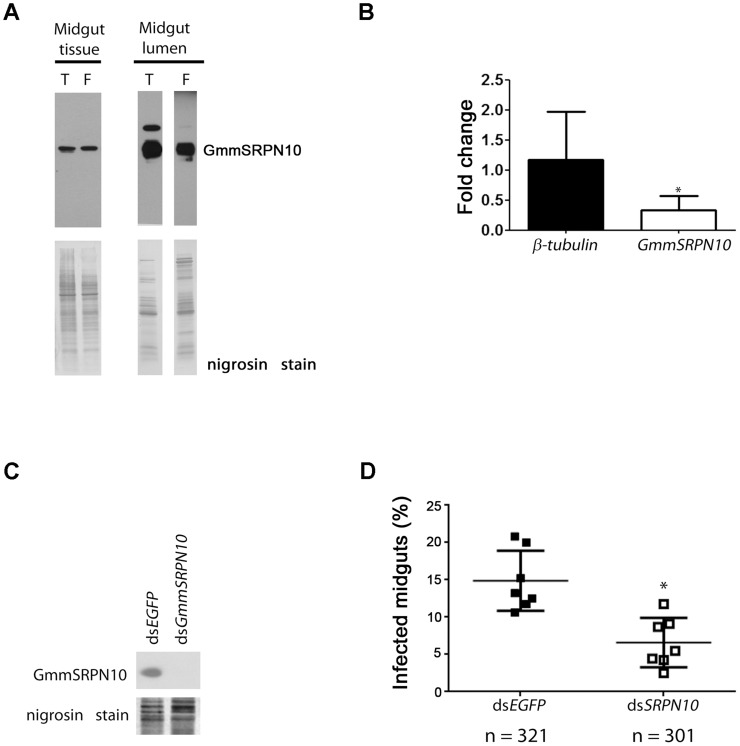
GmmSRPN10 is secreted into the midgut lumen and is important for PF infection.(A) Western blot (using α-GmmSRPN10 antisera) analyses of midgut tissue and midgut lumen content from teneral (T) and fed (F) tsetse suggests that GmmSRPN10 (arrow) is secreted into the midgut lumen in teneral (newly emerged and yet unfed) flies in preparation for blood feeding. Lower panel, stained PVDF membrane with nigrosine. (B) Comparison of β-tubulin and GmmSRPN10 transcript levels between GmmSRPN10 knockdown and control tsetse at the point of dissection at ten days post trypanosome infection indicate that β-tubulin transcript levels remain relatively unchanged in knockdown flies while GmmSRPN10 transcript is significantly decreased to less than 50% (bars represent 3 independent experiments). (C) Downregulation of GmmSRPN10 protein in midguts from dsGmmSRPN10 treated knockdown flies. (D) The knockdown of GmmSRPN10 results in a small but significant decrease in PF midgut infection, suggesting that the expression of GmmSRPN10 is important for PF survival (each data point represents a biological replicate, with a total of >300 flies dissected scored for infection per treatment).